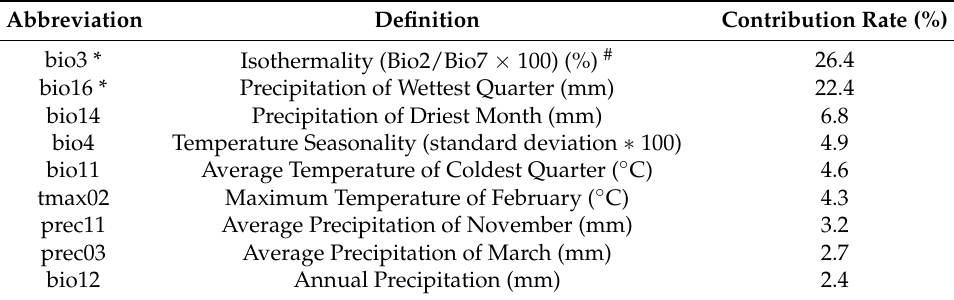
Table 2. Nine screened climatic factors and their contribution rates. Figure 2. Heat map of Pearson’s correlation coefficient.